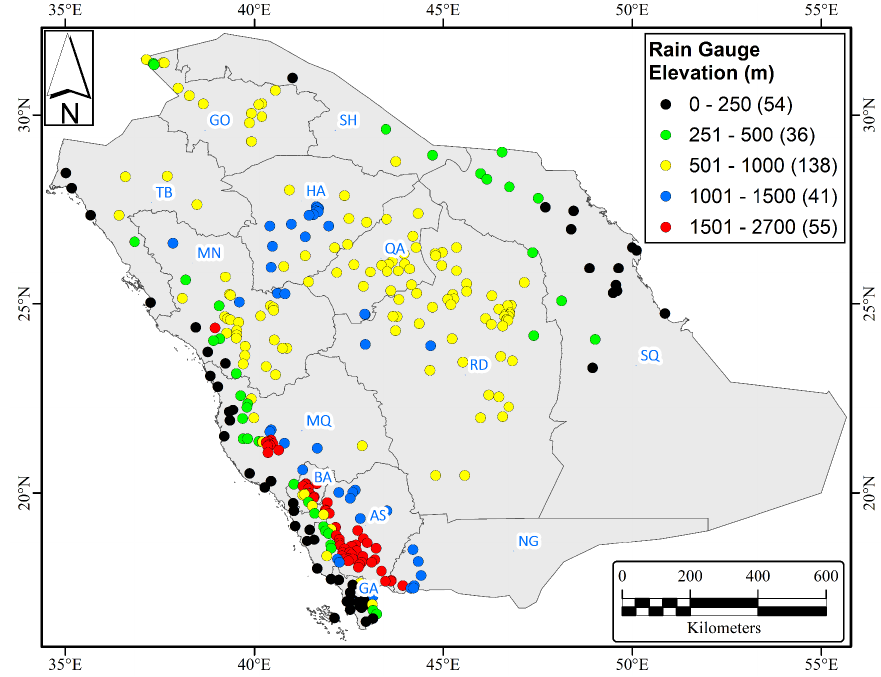
Figure 3. Rain gauges elevations and distribution over KSA administrative zones for different analysis periods. Table 4. Distribution of rain gauges in the KSA administrative